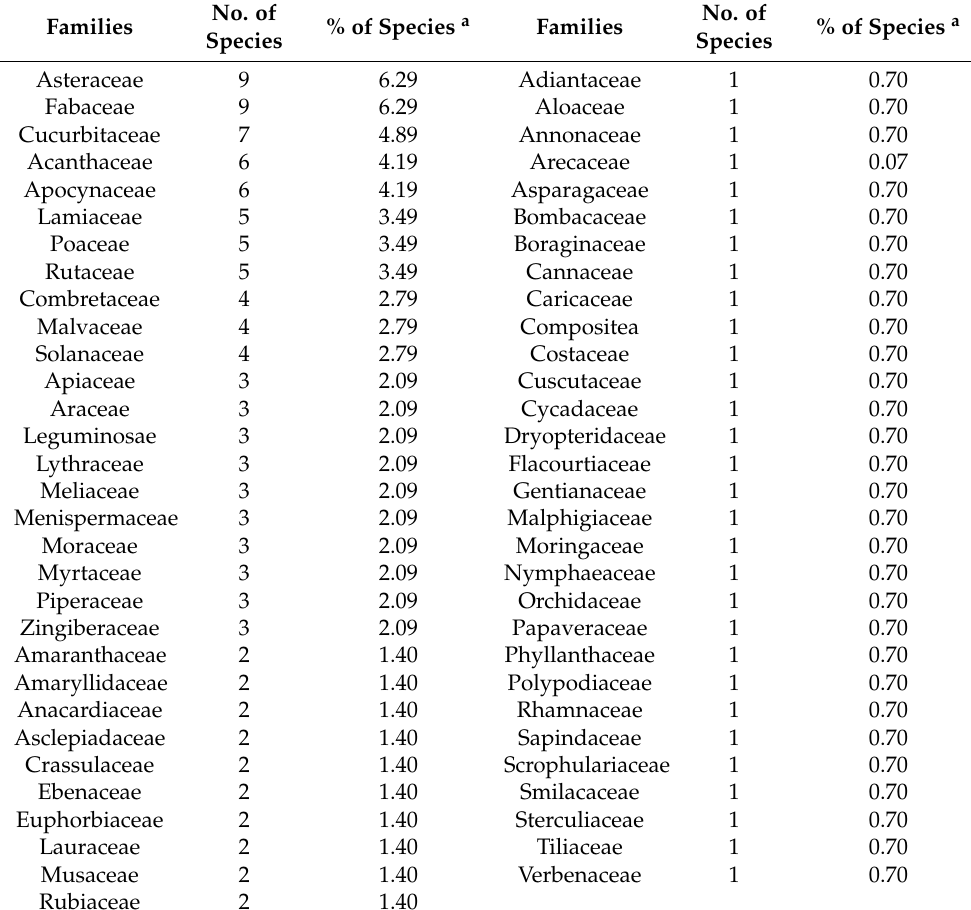
Table 2. Presentation of the antidiabetic plant species of Bangladesh in 61